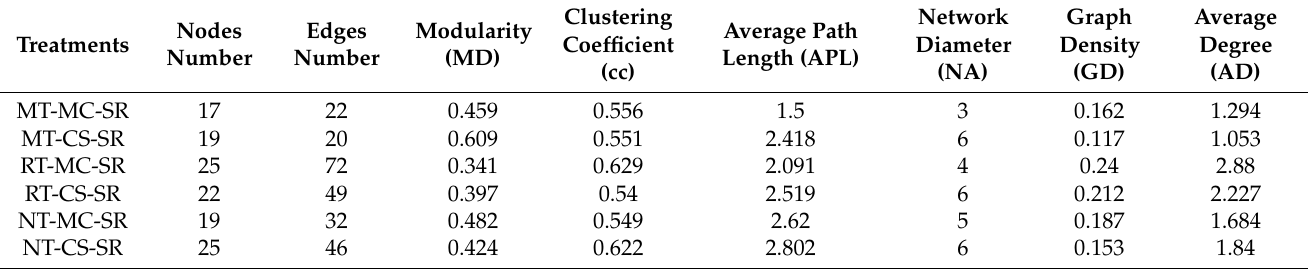
Table 3. Network data for the communities of six treatments (RT-MC, RT-CS, MP-MC, MP-CS, NT-MC, NT-CS) were included in this experiment to identify the correlation between